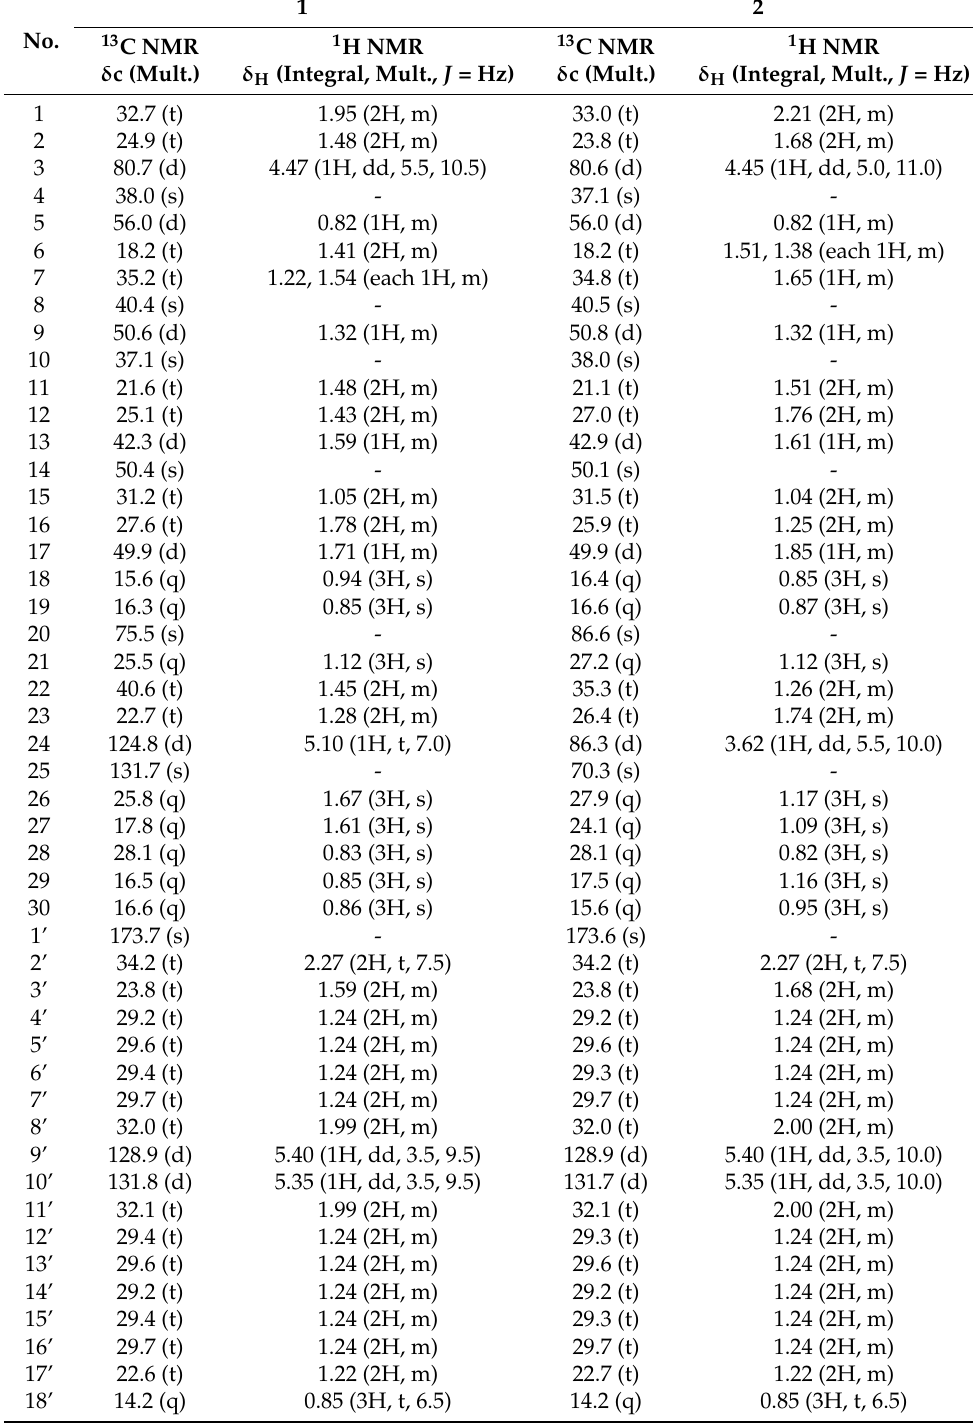
Table 1. NMR Data (500 MHz for 1 H and 125 MHz for 13 C, in CDCl 3 ) for 1 and 2